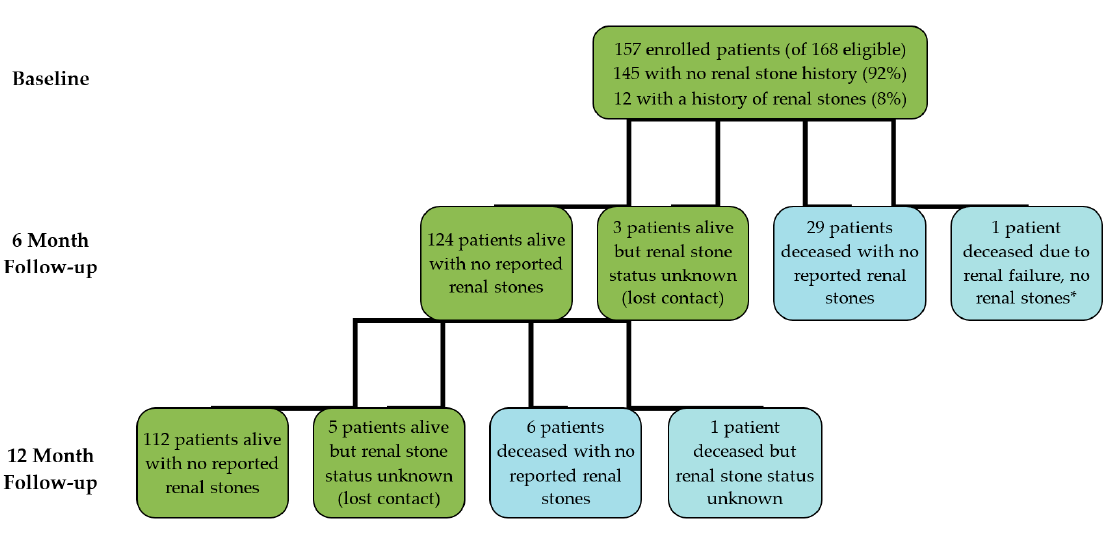
Figure 1. Flow diagram of participants involved in analysis of reported renal stones. * See Patient A case report.